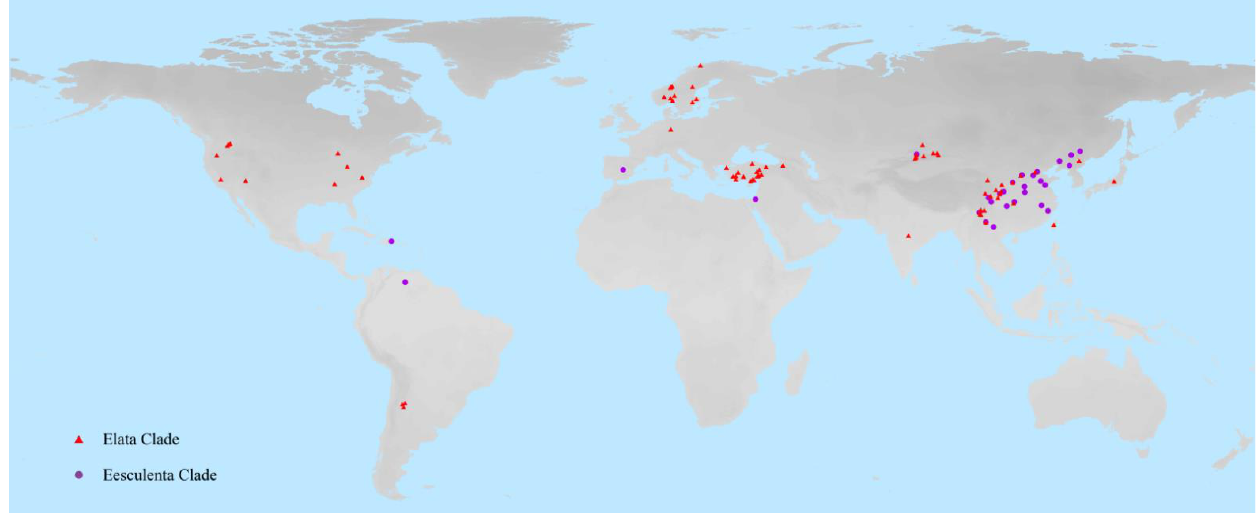
Figure 1. The sampled geographic locations of Morchel la species. The red triangle indicates the geographical distribution of the Elata Clade (black morels), and the purple circle represents the Esculenta Clade (yellow morels).